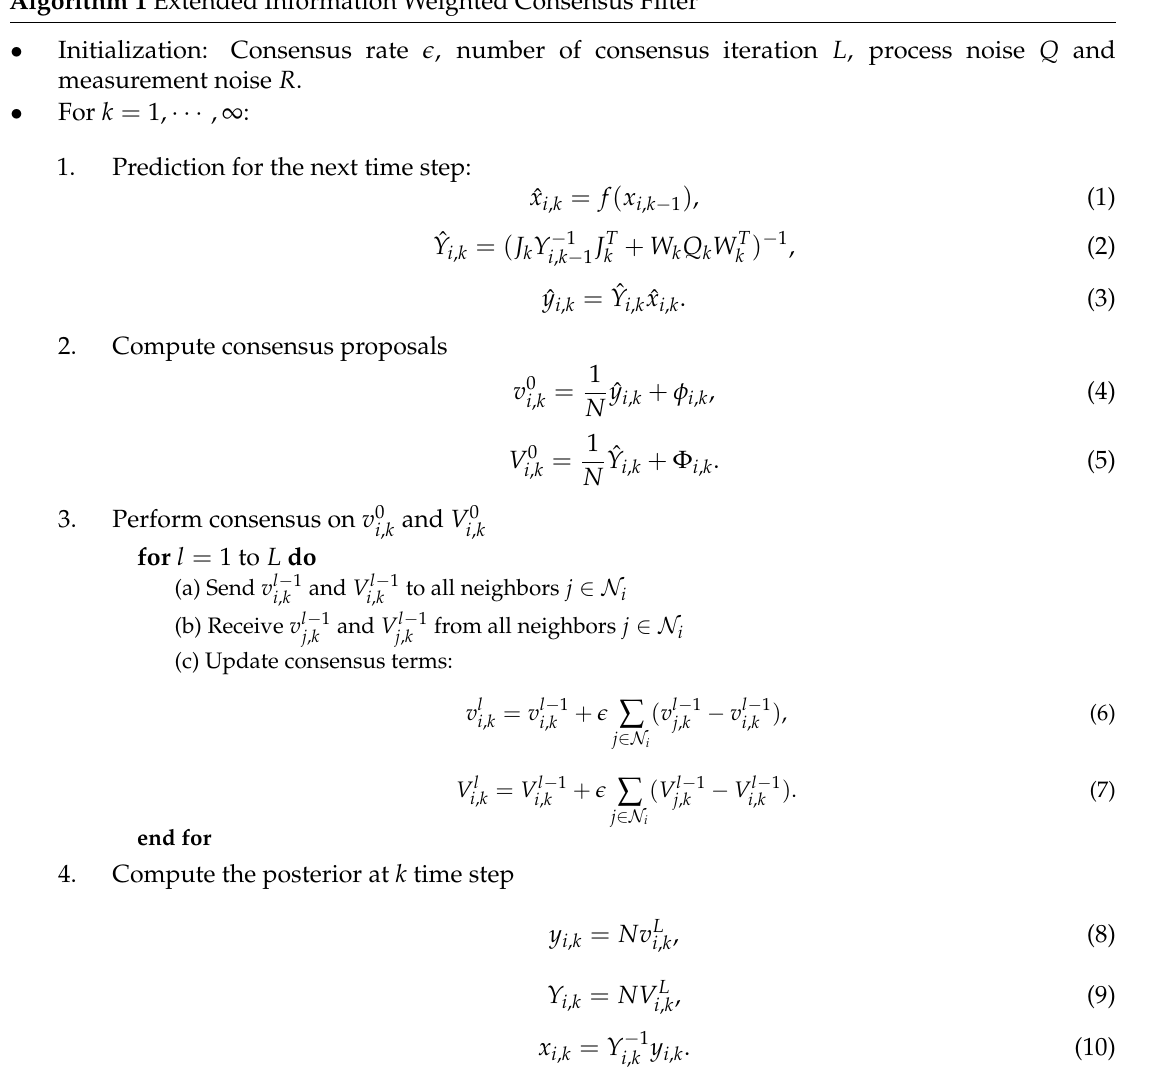
Algorithm 1 Extended Information Weighted Consensus